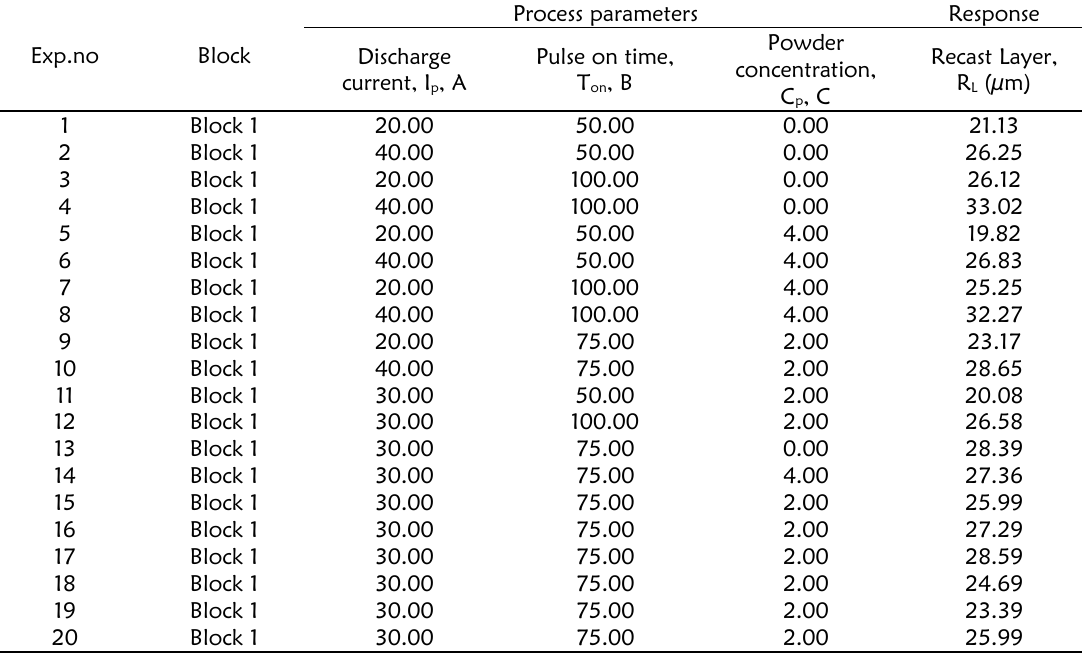
Table 4: Design layout and experimental response for the